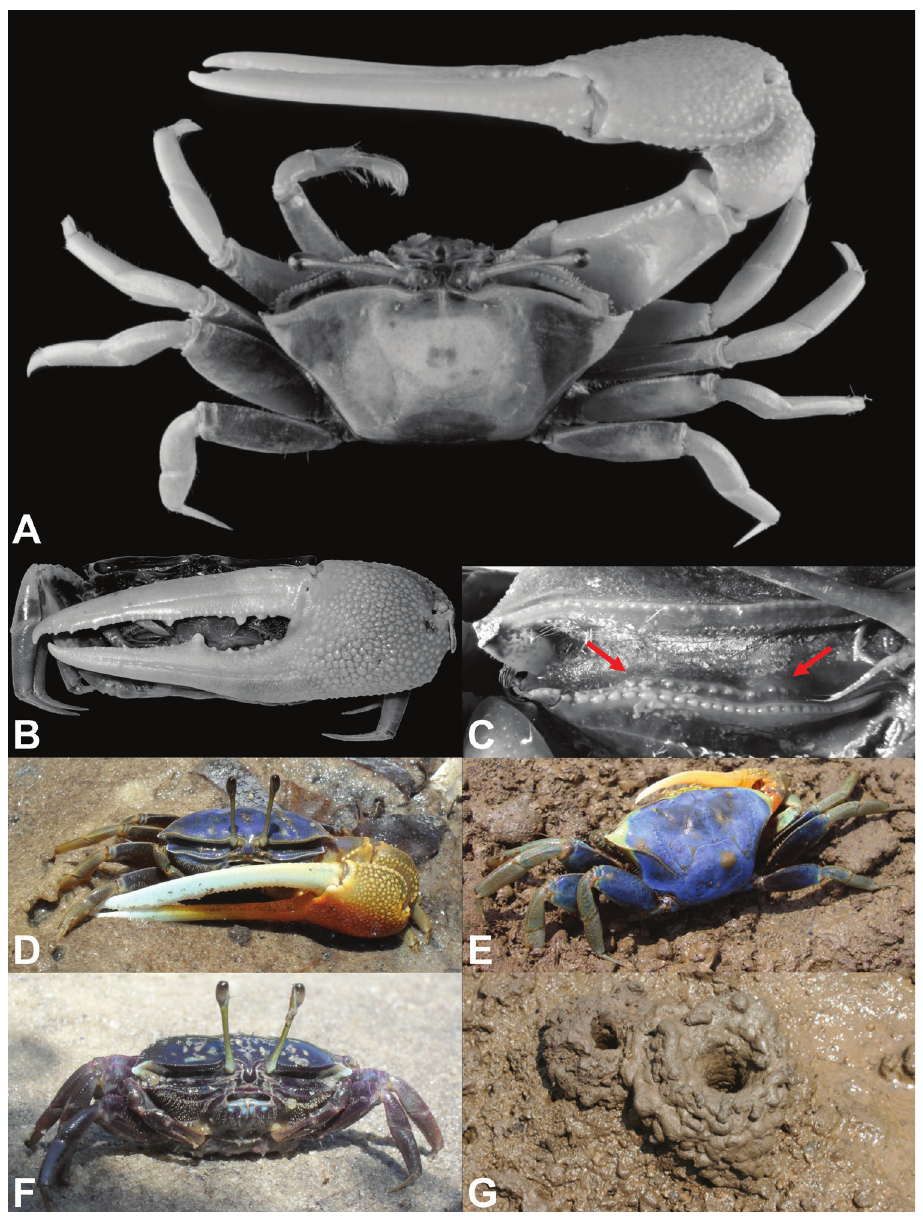
Figure 2. Tubuca urvillei (H. Milne Edwards, 1852) A male (CW 29.7 mm, ZRC 1999.1107; Mayotte) B–C male (CW 34.9, NCHUZOOL 14895; Kenya). A dorsal view B major cheliped C floor of right orbit of showing the tubercles (arrowed). D–F live colouration. D male from Kenya E male from Mayotte F female from Kenya G chimneys built by T. urvillei in Mayotte D, F courtesy of S. Cannicci E, G courtesy of J.